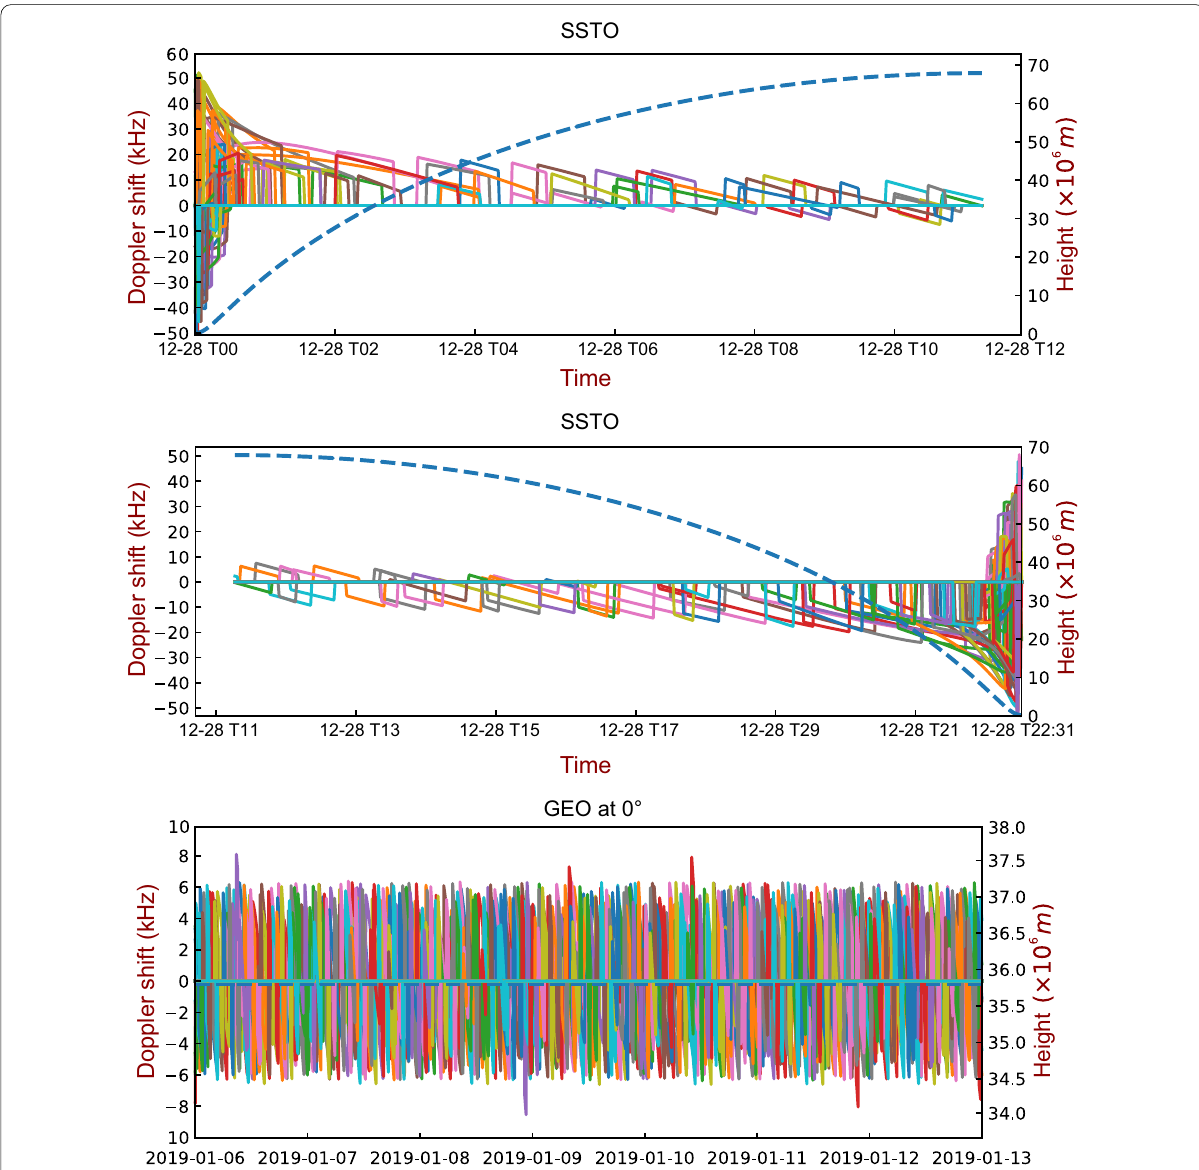
Fig. 13 The Doppler shift during the different